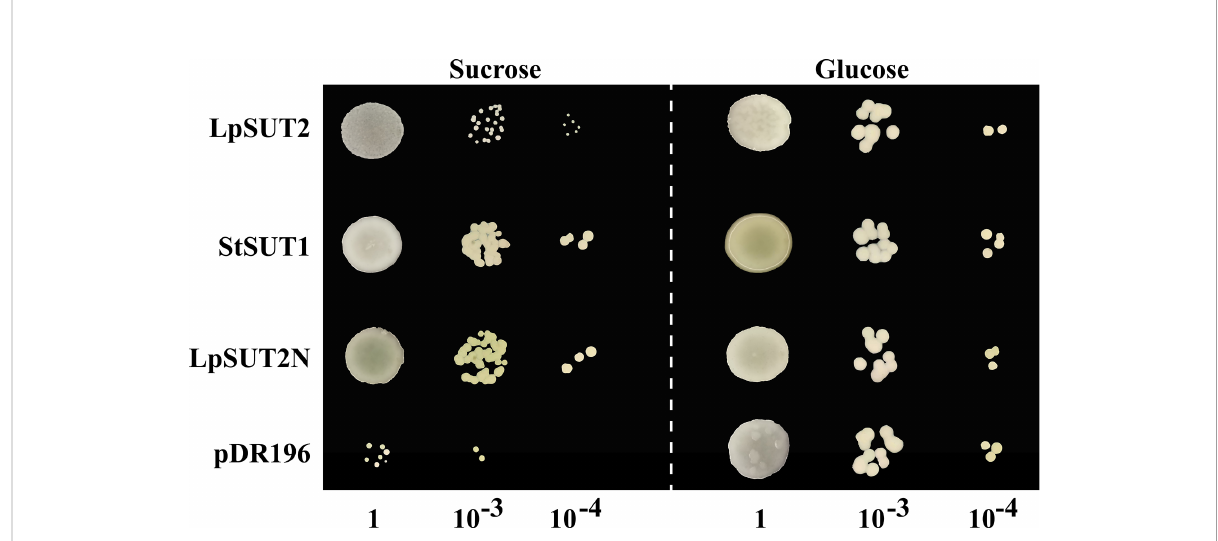
FIGURE 2 Functional analysis of LpSUT2 protein by yeast complementation assay. Sucrose uptake-de fi cient mutant yeast strains SEY6210 transformed with LpSUT2, LpSUT2N, StSUT1 (positive control), and pDR196 empty vector (negative control) were grown on a medium of 2% sucrose and 2% glucose (positive control) as sole carbon source. The plates were incubated at 30°C for 2-3 days, and the colonies were observed at different dilution times. LpSUT2, Sucrose transporter 2 of L. punctata ; StSUT1, Sucrose transporter 1 of Solanum tuberosum